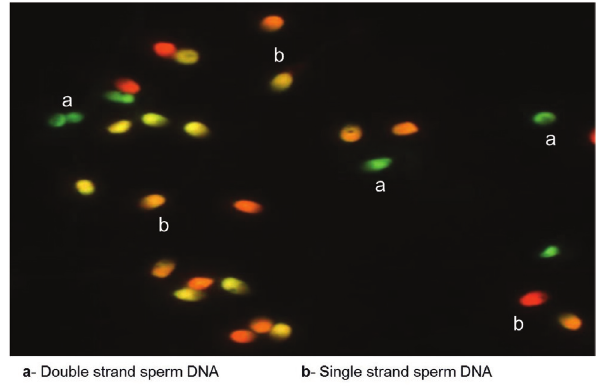
Figure 2 An example of acridine orange staining